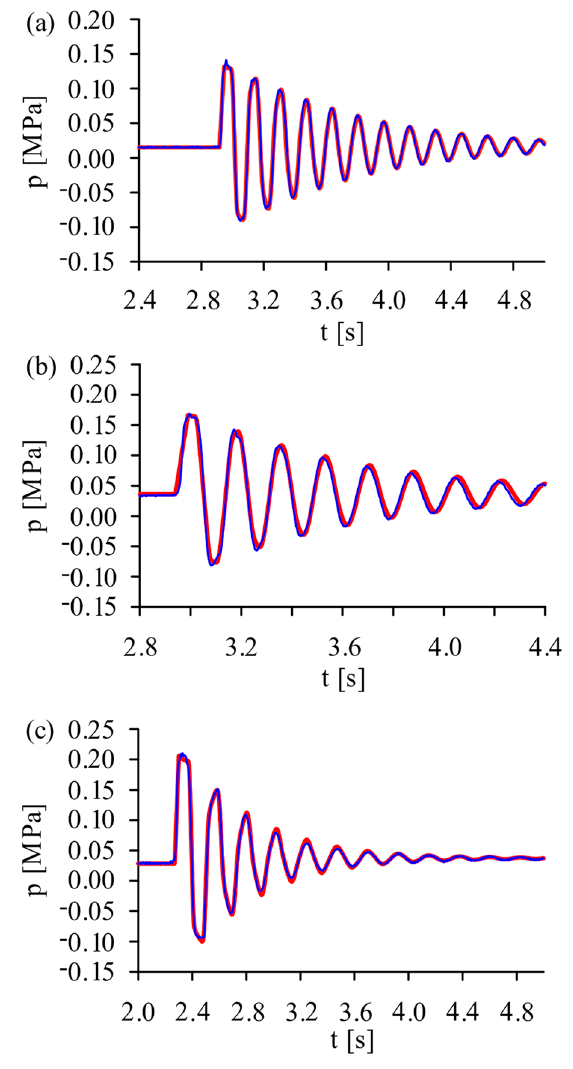
Figure 7. Pressure characteristics: measured (blue line) and calculated (red line) with use of equivalent density concept: ( a ) water, ρ eq = 1000 kg/m 3 ; ( b ) slurry, C V = 0.007, ρ eq = 1076 kg/m 3 ; ( c ) slurry, CV = 0.039, ρ eq = 1790 kg/m 3 .